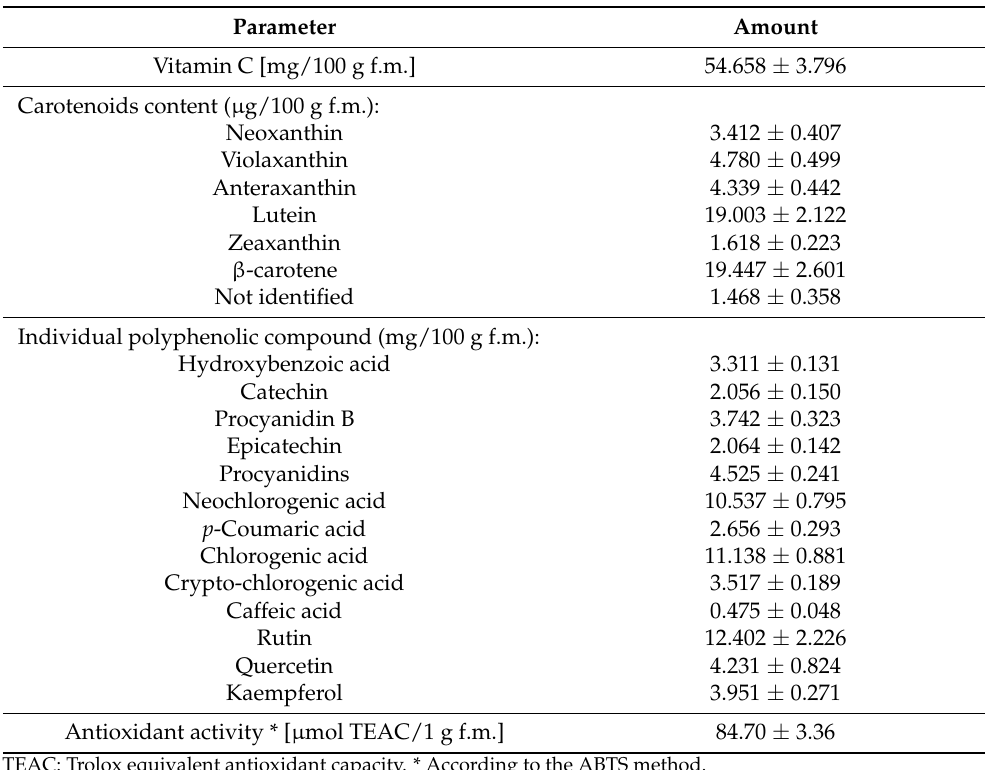
Table 1. Characteristics of kiwiberries used in this study ( n = 6).